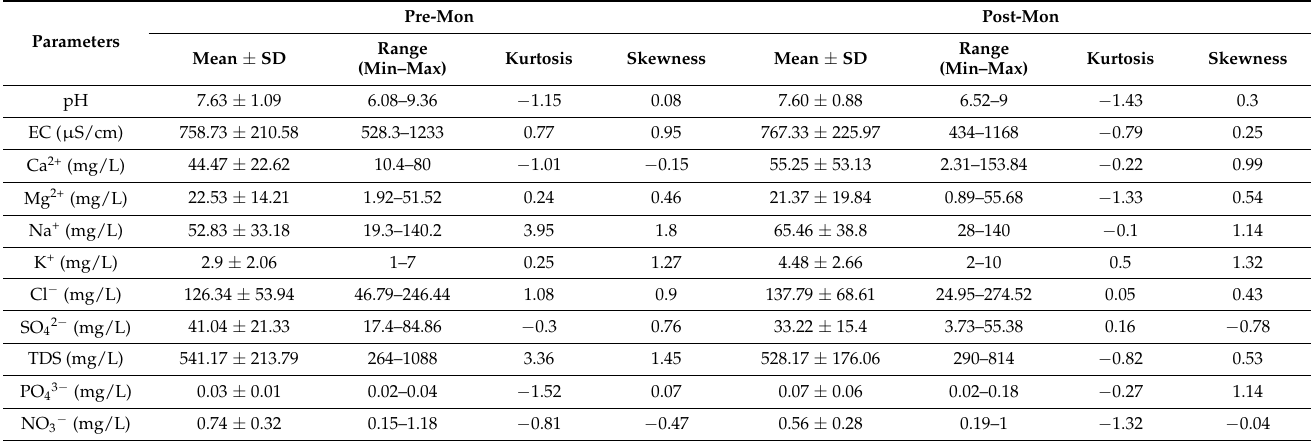
Table 4. Descriptive statistics of physicochemical parameters of